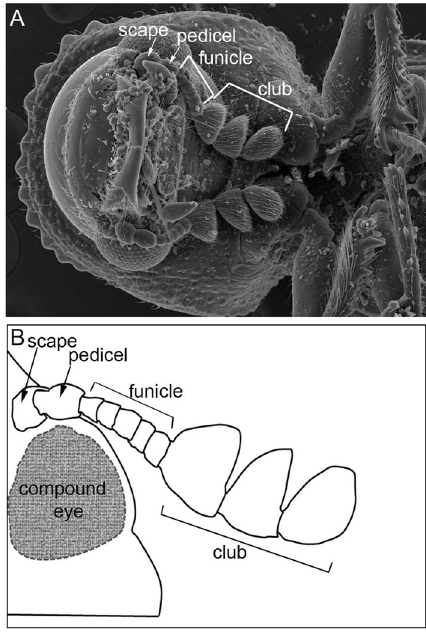
Fig. 1 Whole antenna of adult Rhyzopertha dominica . A Scanning electron micrograph (SEM) of head and the projected antennae; flagellomeres were arranged as a proximal narrow funicle (fl1–fl5) and a distal wide club (cl1–cl3), pe—pedicel, sc—scape; scale bar 50 μm. B Schematic drawing of the whole antenna showing = the proximal funicle and distal club